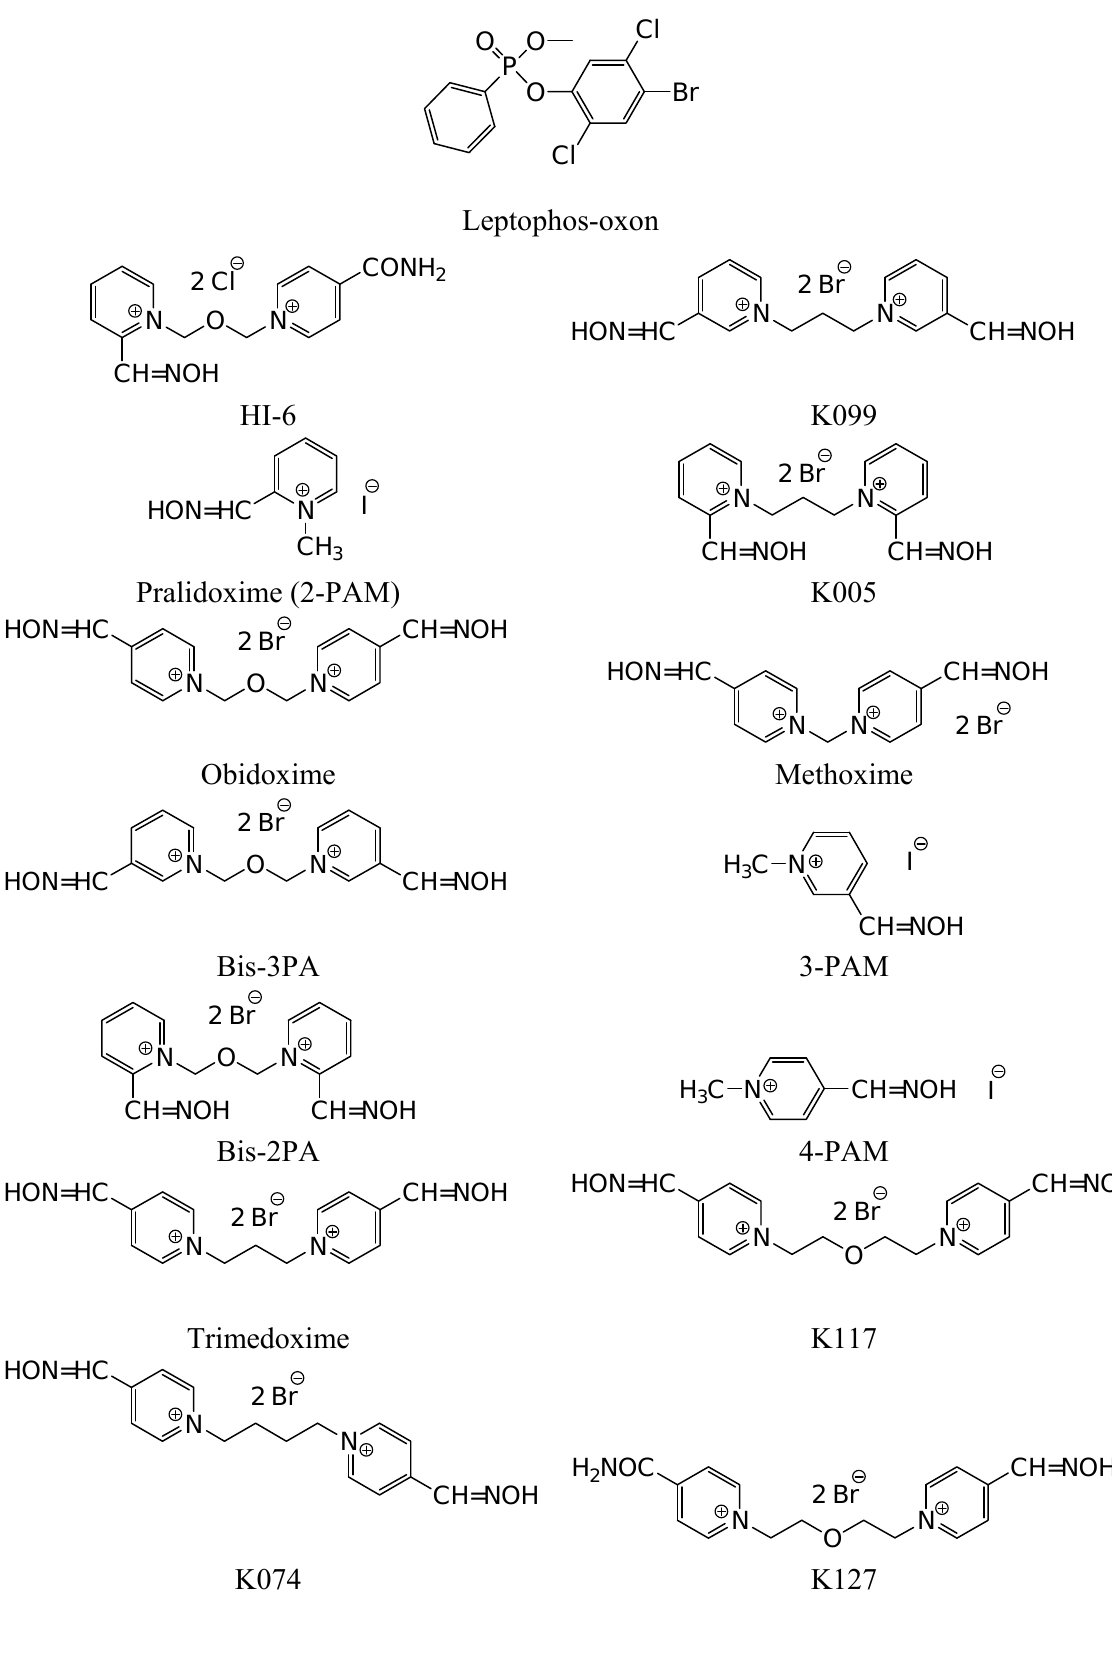
Figure 1. Structure of leptophos-oxon and tested oxime